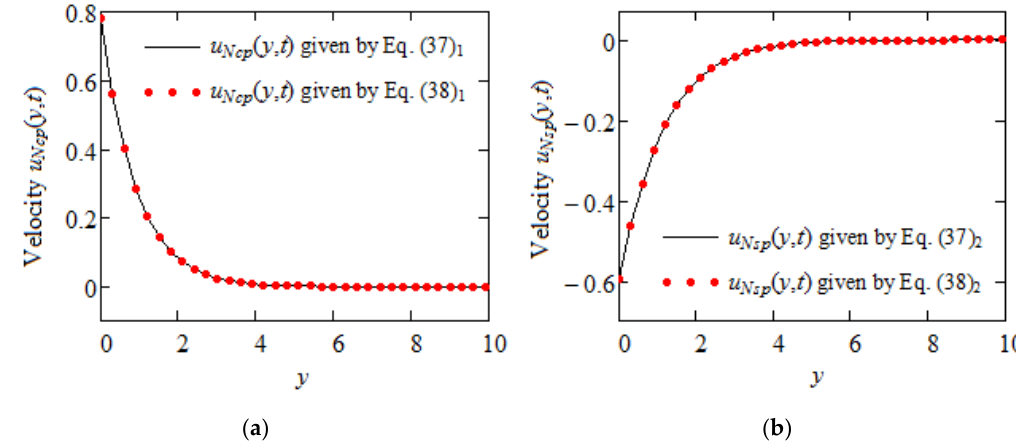
Figure 2. Equivalence of velocity fields u Ncp ( y , t ) and u Nsp ( y , t ) given by Equations (37) and (38) for ω = π /12, K ef f = 1, and t = 10